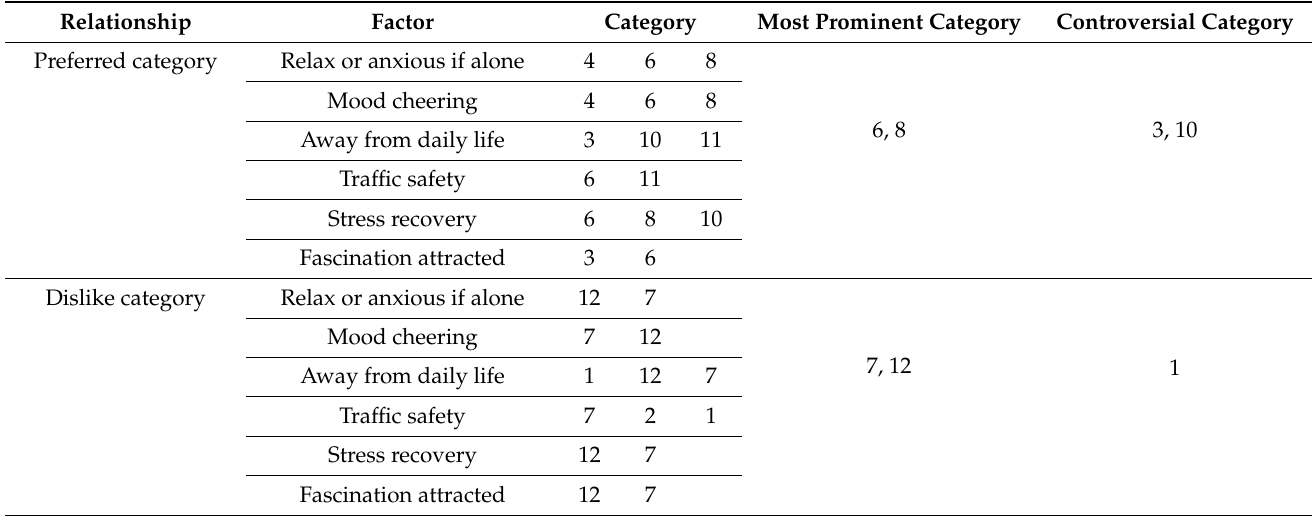
Table 5. Space category signification and main finding.